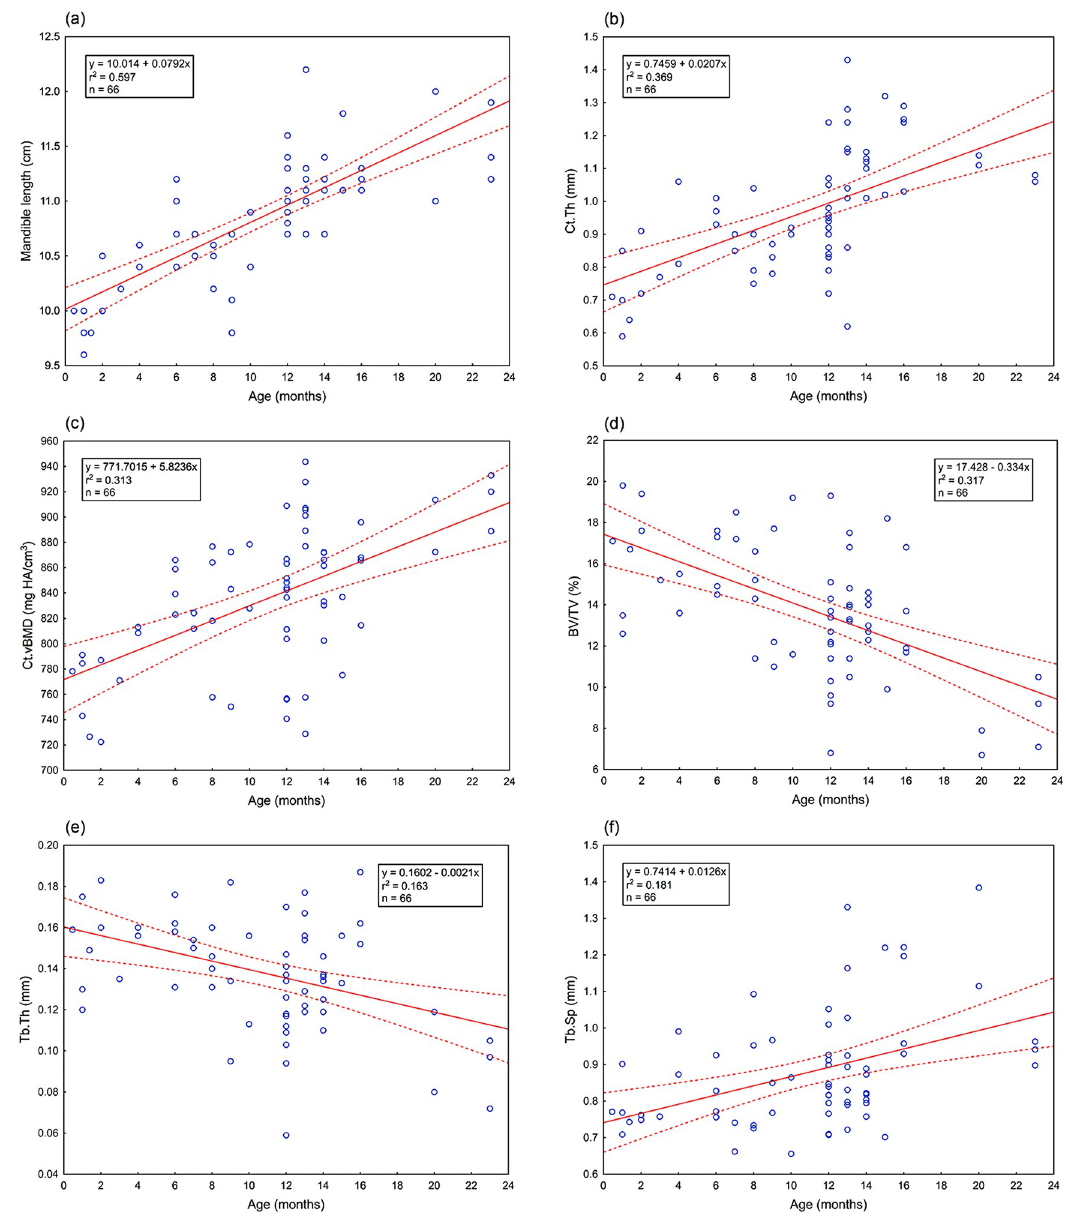
Fig 3. Relationship between age and morphological (length, cortical thickness), mineralization (cortical volumetric bone mineral density) and microarchitectural parameters (trabecular bone volume fraction, trabecular thickness and trabecular separation) in mandibles of juvenile harbor seal ( Phoca vitulina ) individuals (age range: 0.5 to 23 months, n = 66). The dashed lines indicate 95% confidence bands for the